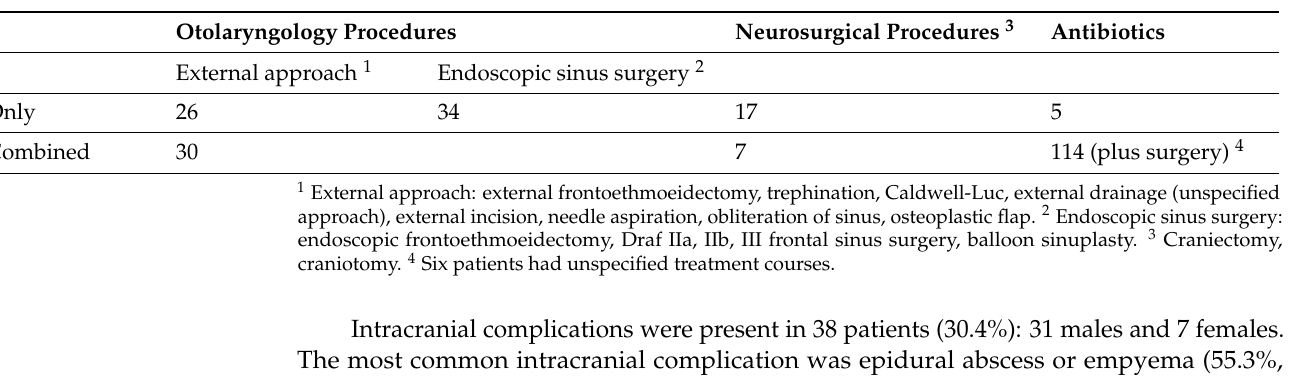
Table 2. Treatment course and surgical management.